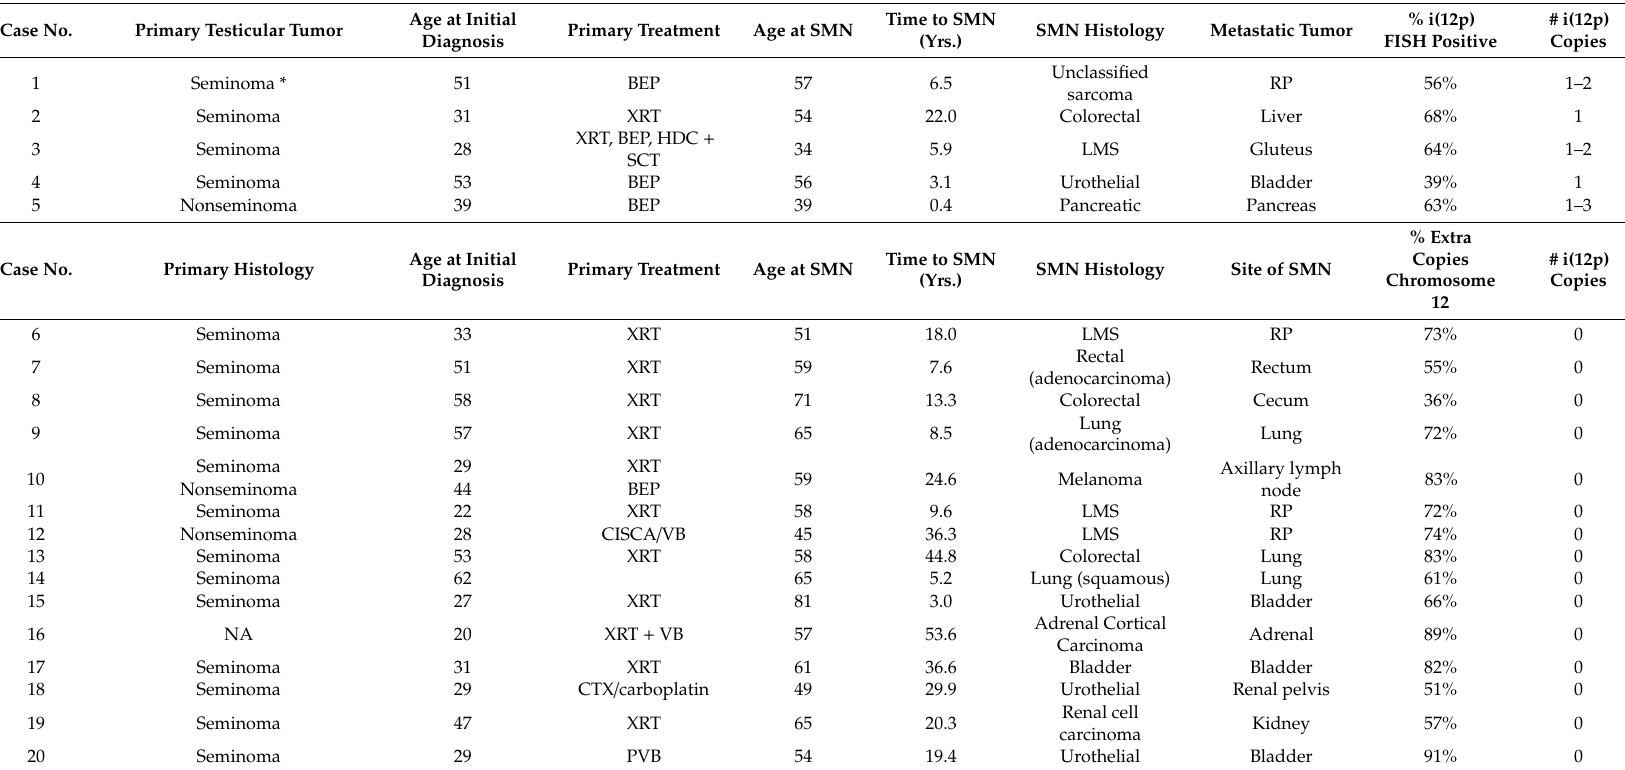
Table 2. Detection of i(12p) or additional copies of chromosome 12 without i(12p) by fluorescence in situ hybridization (FISH) in primary tumors and SMNs. Case